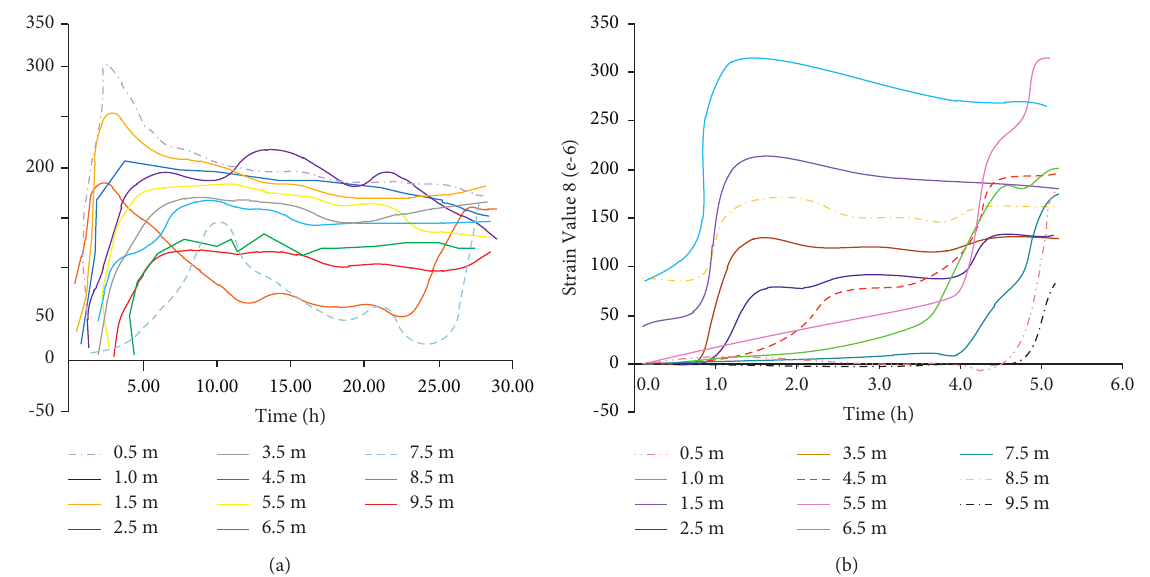
Figure 5: Curves of horizontal strain-time. (a) Horizontal strain of steel plate at different heights of parts. (b) Square diagram of horizontal strain curve of steel plate.